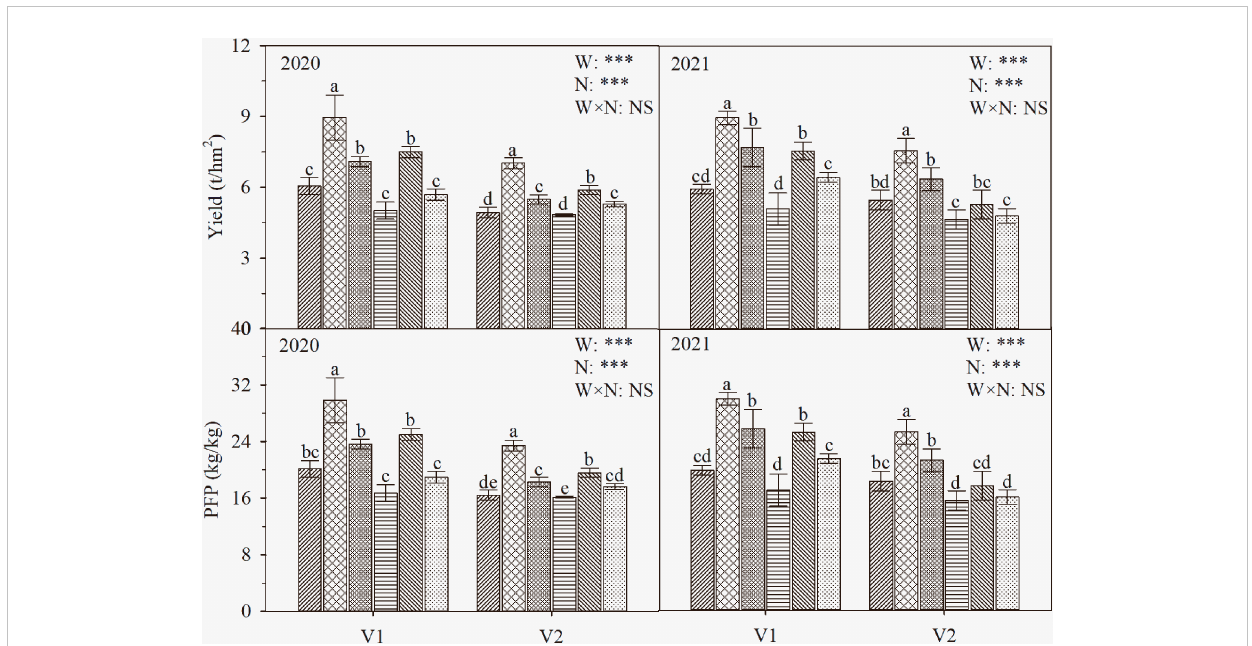
FIGURE 8 The yield and PFP of rice under different treatments. The data are presented as the means of three replicates (n = 3). Error bars indicate standard error (SE). W 1 and W 2 represent limited irrigation (10200 m 3 ·hm -2 ) and de fi cit irrigation (8670 m 3 ·hm -2 ), while N 1 , N 2 , and N 3 represent different ratios of seedling fertilizer:tillering fertilizer:panicle fertilizer:grain fertilizer (30%:50%:13%:7%; 20%:40%:30%:10%; and 10%:30%:40%:20%, respectively). PI, HS, and 20 DAH represent panicle initiation, heading stages, and 20 days after heading, respectively. V1 and V2 represent T-43 and Liangxiang-3, respectively. *** represents a signi fi cant difference at the 0.001